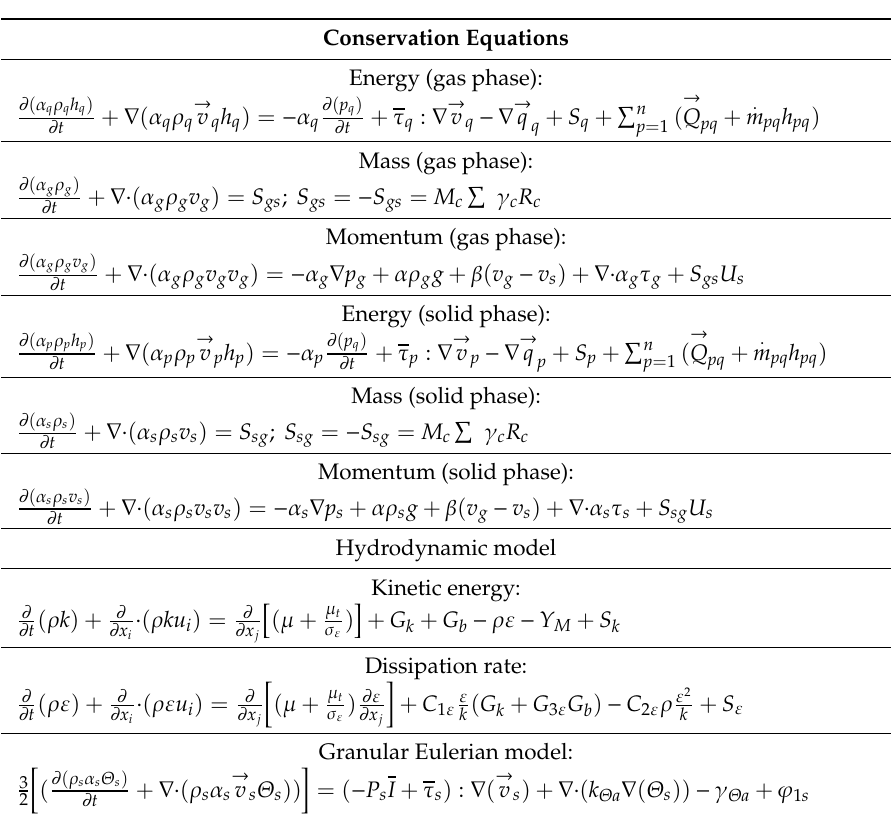
Table 4. Conservation equations and hydrodynamic model for both gas and solid